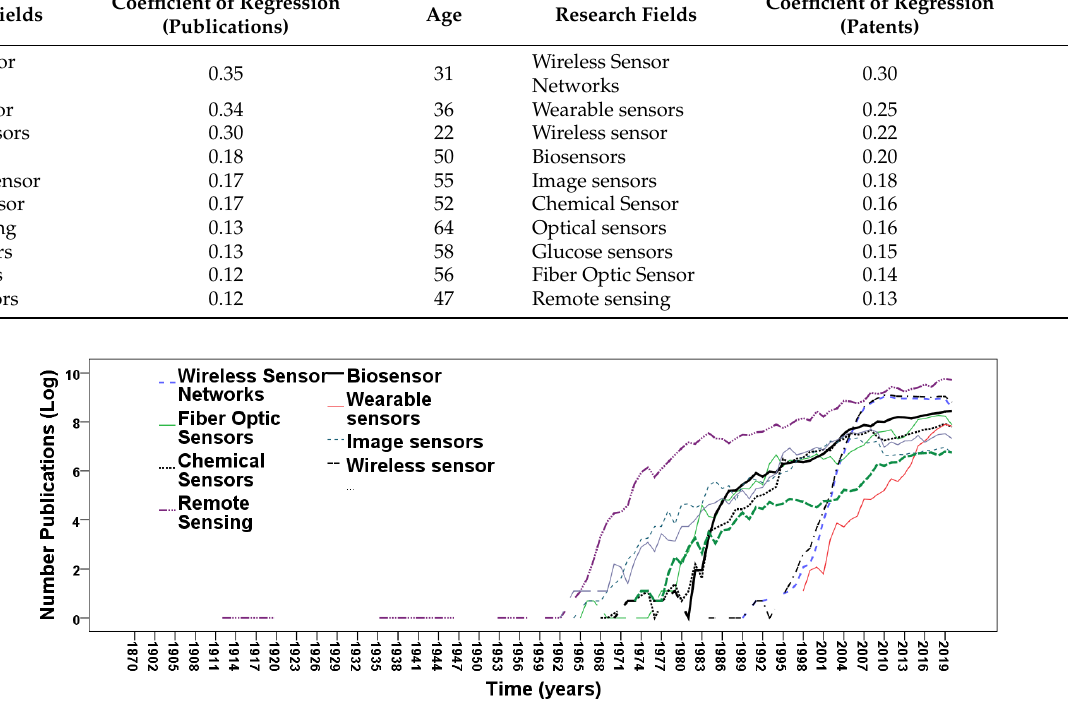
Figure 2. Trends of research fields in sensors using scientific production ( log scale).